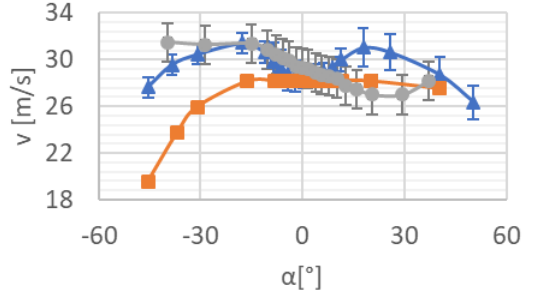
Fig. 21. S, L-type and QuadraTherm velocity probe declination measurement, mean velocity 28 m/s